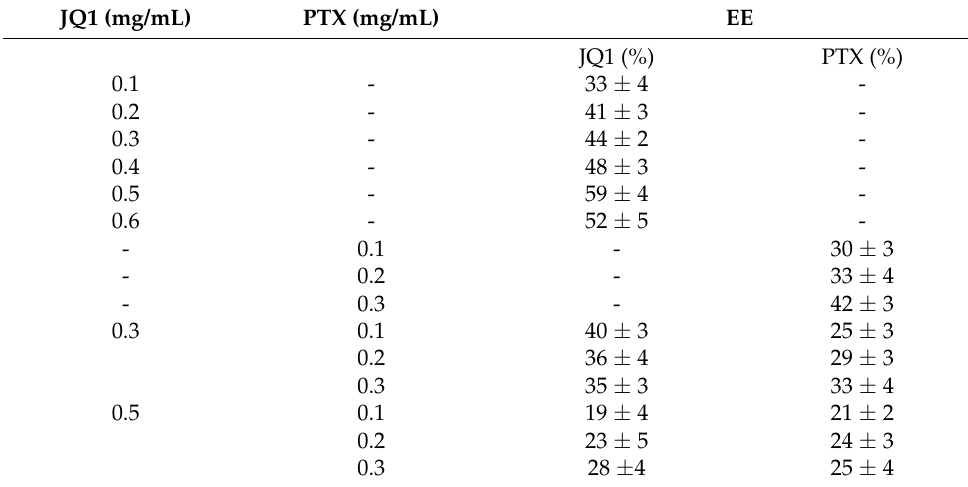
Table 2. Entrapment efficiency of JQ1 and PTX within zein nanoparticles as a function of the drug